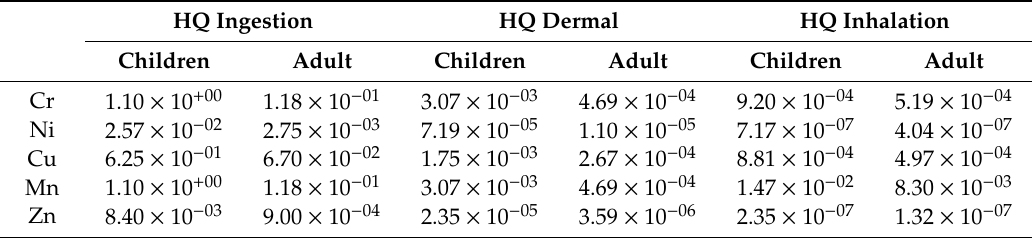
Table 7. Hazard quotient (HQ) values for various pathways and elements resulting from exposure to soil elements, Uttarakhand,